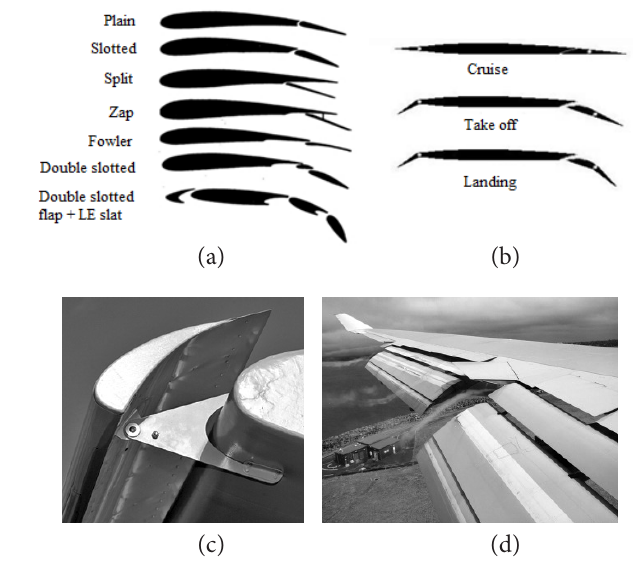
Figure 1. Position of high lift devices (a) Different types of flap and slat configurations on aircraft wing (IATA, 2019) (b) Position of flap and slap devices during aircraft operation modes (Haroon, 2011) (c) Ventilated and fixed leading edge slat (d) Slotted flaps of Boeing 747-400 during landing